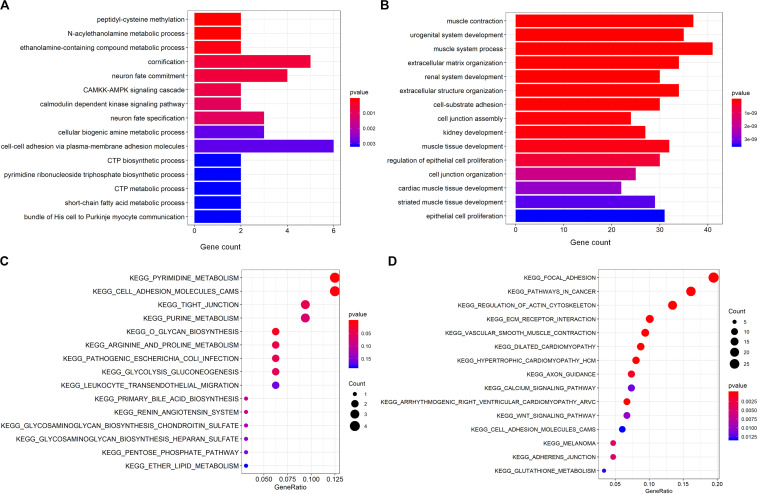
GOBP and KEGG enrichment on the commonly appeared differentially expressed genes. (A,B) GOBP enrichment analysis on the commonly up regulated genes and down regulated genes. The y-axis is GOBP term, and the x-axis is the number of genes enriched to the corresponding term. (C,D) KEGG pathway enrichment analysis on the commonly up regulated genes and down regulated genes. The y-axis is KEGG pathway term, and the x-axis is the gene ratio representing the proportion of enriched genes in a KEGG pathway term over the number of genes in the inputted gene list.